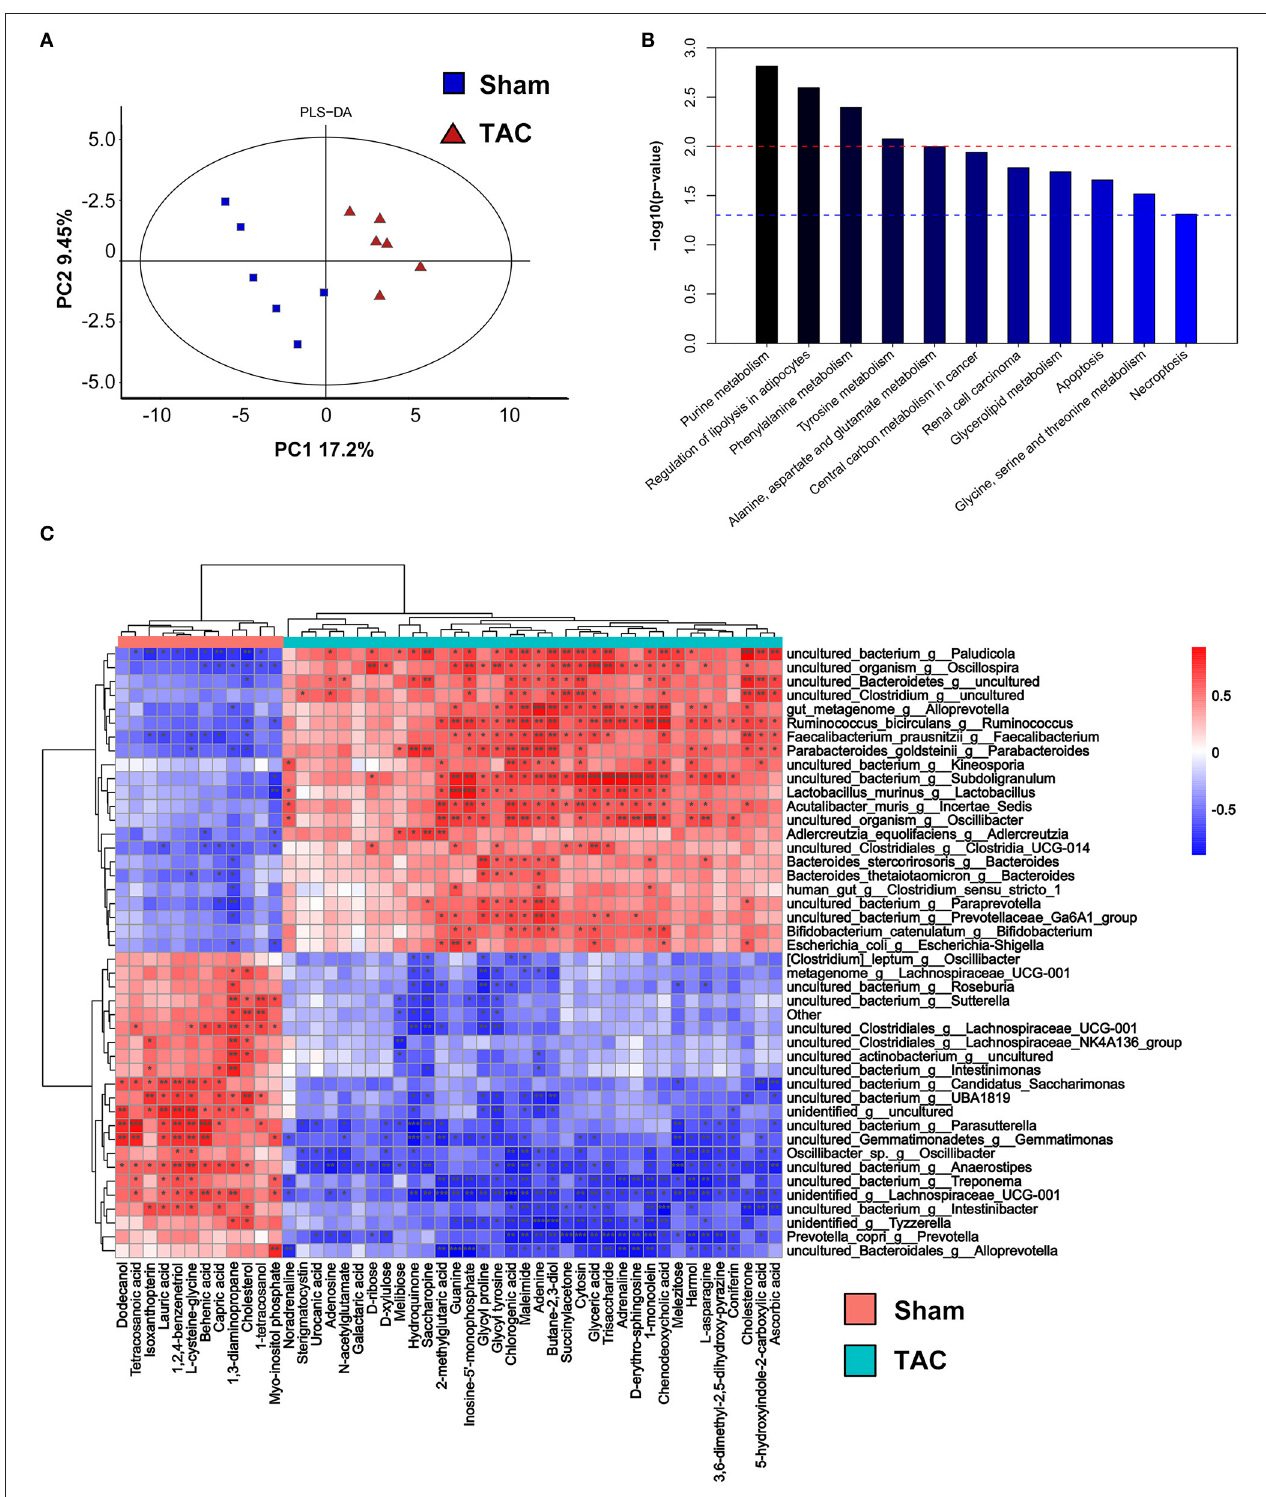
FIGURE 6 | Fecal metabolomics of the surgically treated mice. (A) Partial least-squares-discriminant analysis (PLS-DA) of the metabolites. (B) The differential metabolite functions are predicted by the Kyoto Encyclopedia of Genes and Genomes (KEGG) pathway enrichment analysis. (C) Heatmap of Spearman’s correlations between changes in metabolites and microbiota in the fecal samples. Red indicates a positive correlation, and blue indicates a negative correlation. * p < 0.05, ** p < 0.01, and *** p < 0.001.